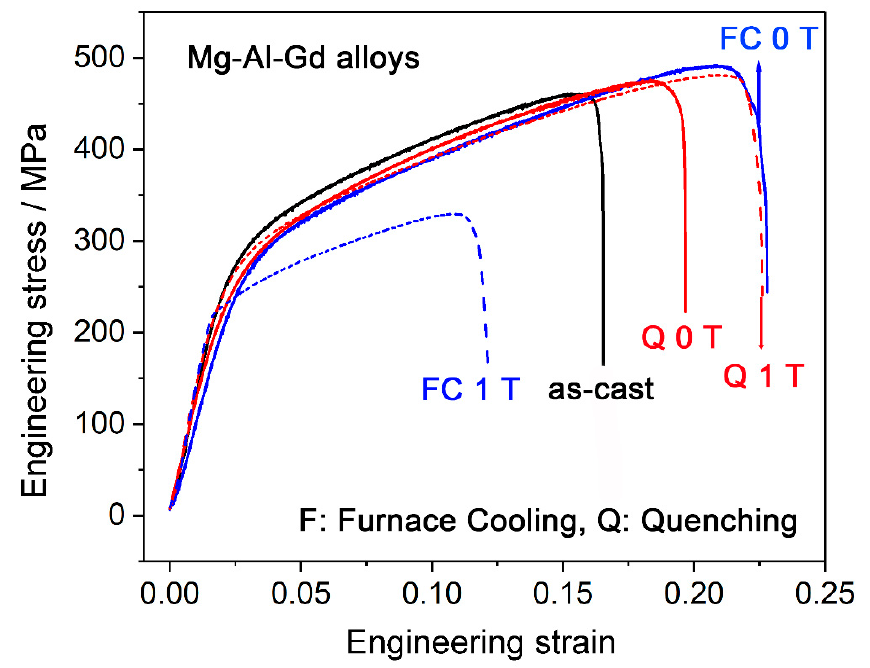
Figure 11. Compressive stress–strain curves of the as-cast Mg–Al–Gd alloy and the furnace-cooled and quenched alloys under 0 T and 1 T.